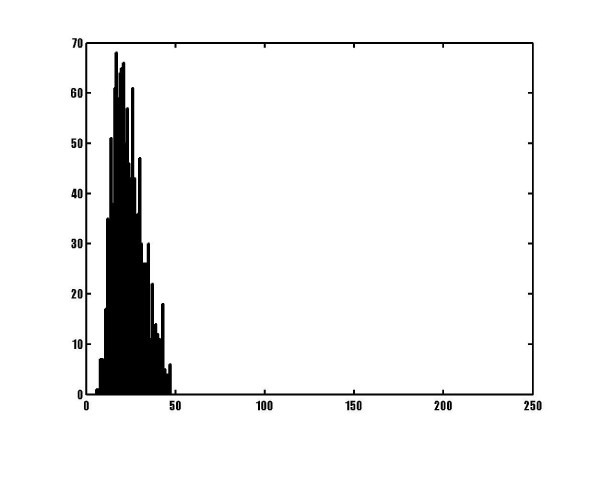
Histogram of similar words for the knirps cis-regulatory module, after shuffling. The frequency distribution of similar words for one randomly shuffled version of the knirps cis-regulatory region, Drosophila melanogaster . The Y axis shows the number of lists, the X axis is for list size.